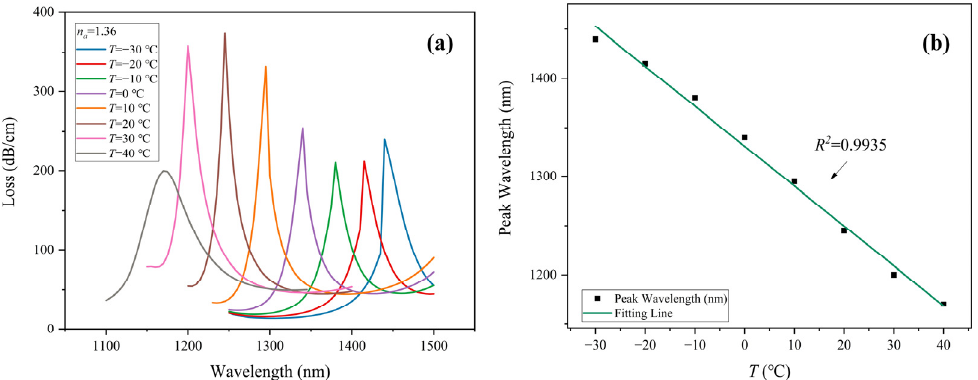
Figure 6. ( a ) CL spectrum of x- polarization core mode under various T from − 30–40 °C when n a = 1.36. ( b ) Resonance wavelength and its linear fitting line under various T from − 30–40 °C when n a = 1.36.